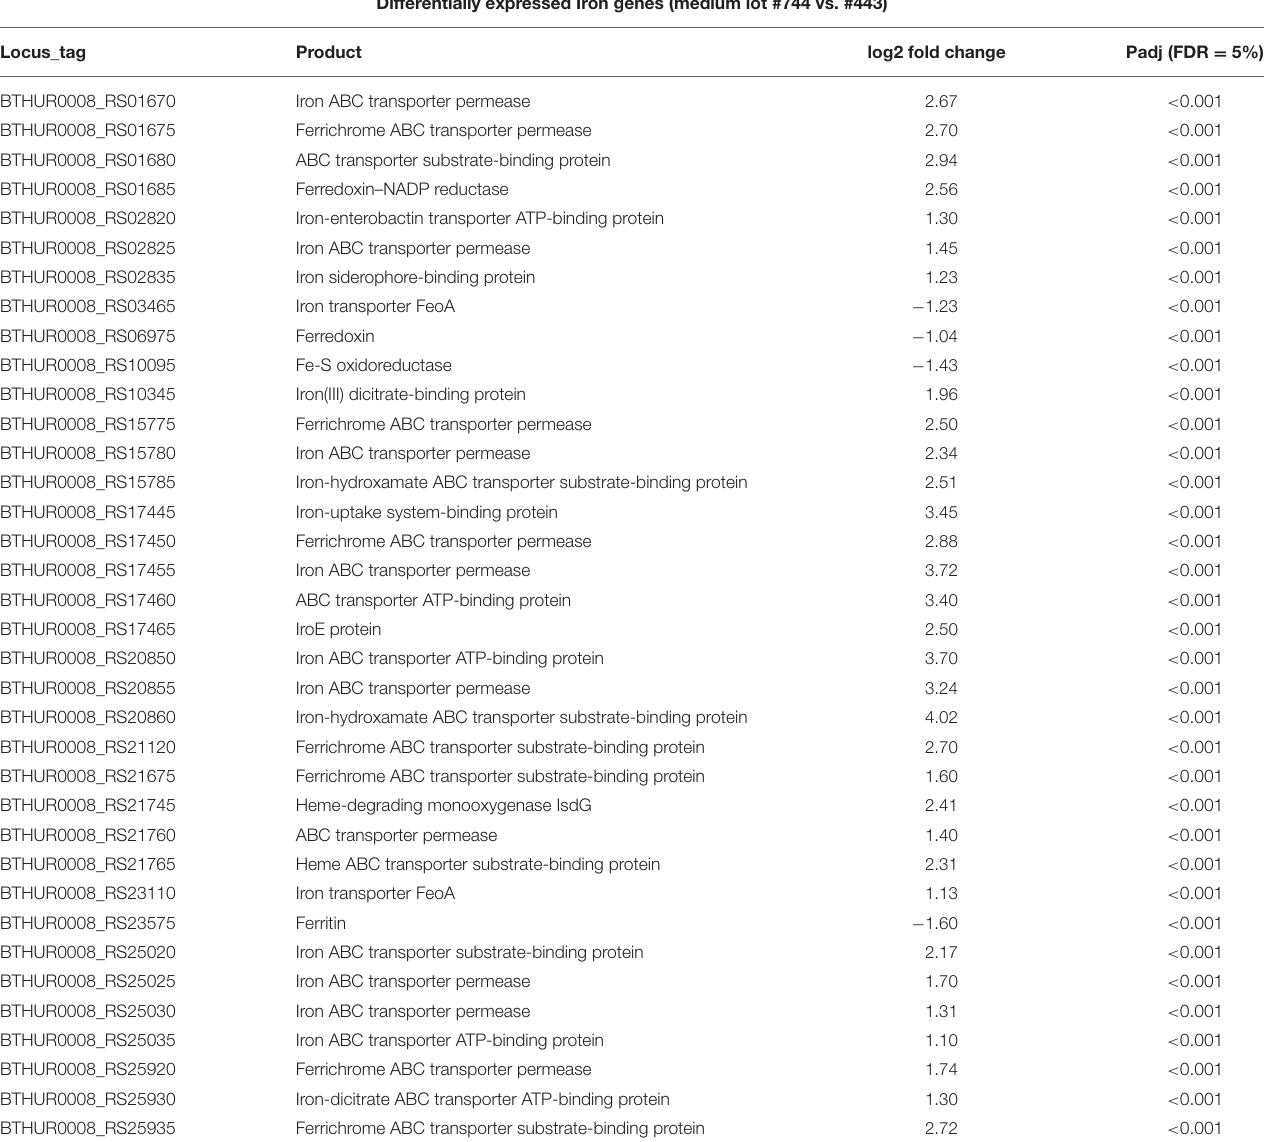
TABLE 2 | Genes related to iron acquisition and metabolism differentially expressed in strain ATCC10792 grown in medium lot #1091744 over #7220443. Differentially expressed Iron genes (medium lot #744 vs. #443)